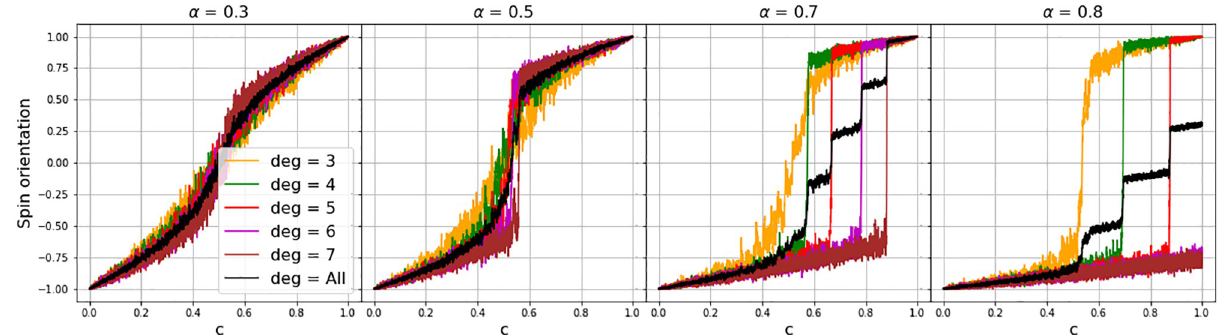
Fig 1. Critical transitions in networked spin-shift model implementation with 2000 nodes in groups of 400 with link degrees deg 2 {3, 4, 5, 6, 7} respectively, and driven over 20000 iterations into an assortativity of 0.99. Varying α -values insinuates that the actual cause of the CT is neighborhood influence. (1) The higher the α -value, the more distinctly the development deviates from the form of a linear transition as it would be expected from simply raising the spin-orientation probability (i.e. what here is called external or factual influence). (2) The higher the α -value, the more the transitions of the individual network clusters get driven apart. And (3), the higher the α -value, the more the overall (i.e. mean) transition (shown in black) is shifted to the right, indicating an hysteresis effect, which is visualized in [16].